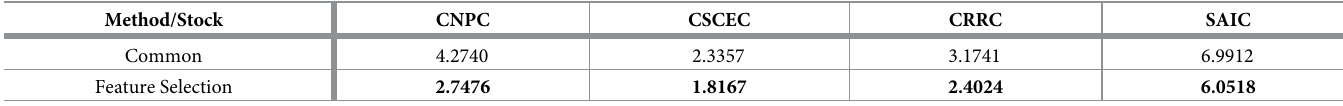
Table 3. MAPE value of common stock obtained by different methods